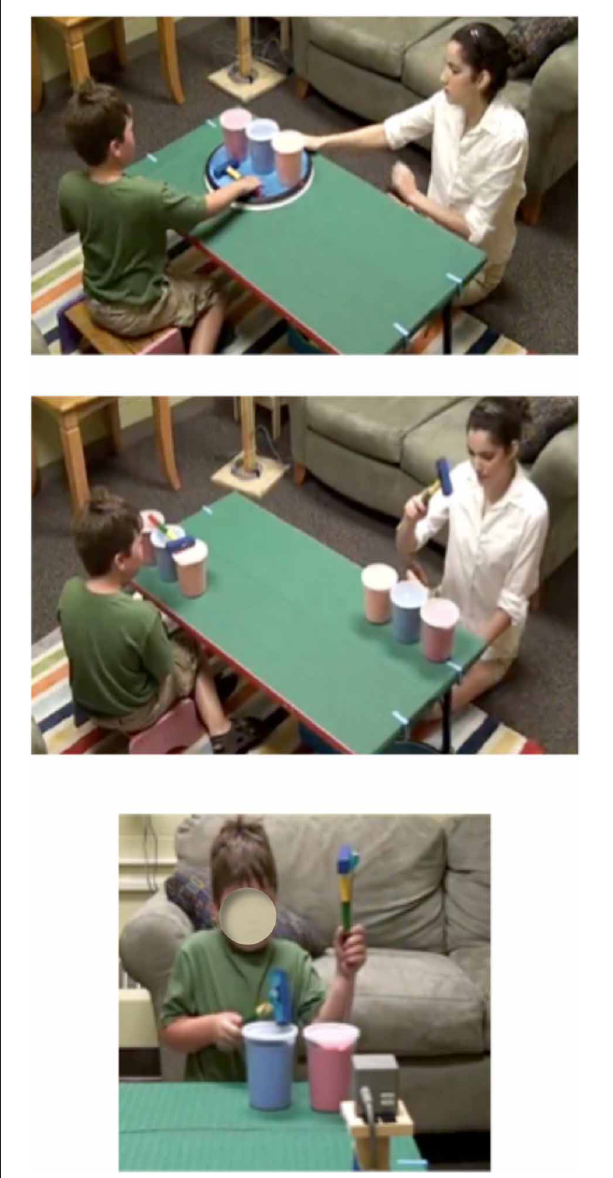
FIGURE 1 | Illustrations of the experimental set-up. The top panel displays the turn-taking cooperation task, the middle panel the imitation and synchrony tasks, and the bottom panel the drumming